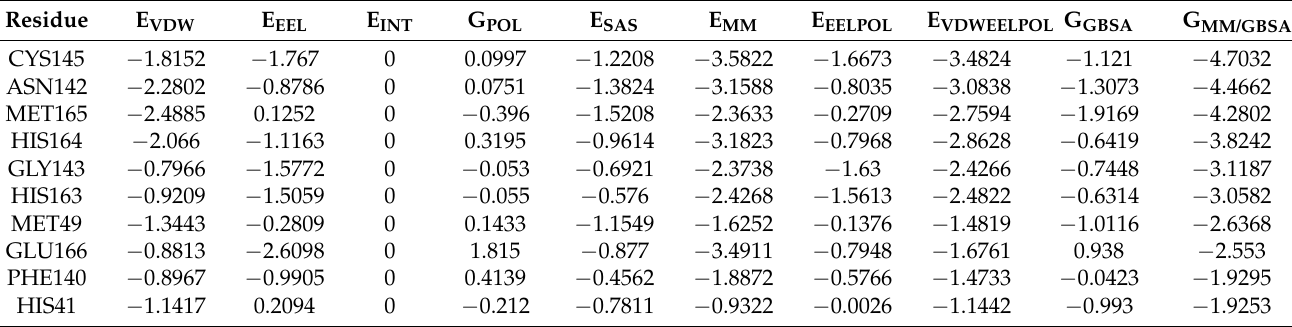
Table 3. Energy decomposition of MM-GBSA free energy for ZINC15676170. All energies are in kcal/mol.